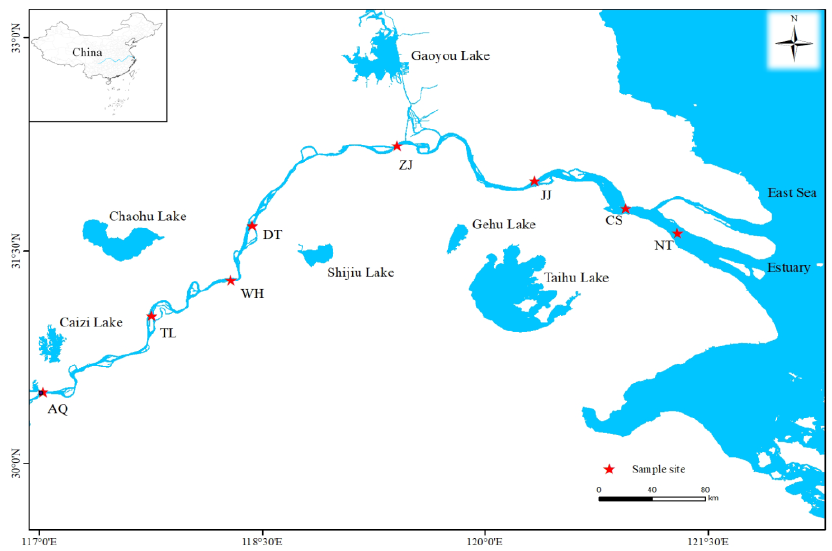
Figure 1. Sampling map of Silver Carp in the lower Yangtze River. Note: AQ, Anqing; TL, Tongling; WH, Wuhu; DT, Dangtu; ZJ, Zhenjiang; JJ, Jingjiang; SC, Changshu and NT, Nantong. Two survey sites were set in each section, one on the left and the other on the right bank.